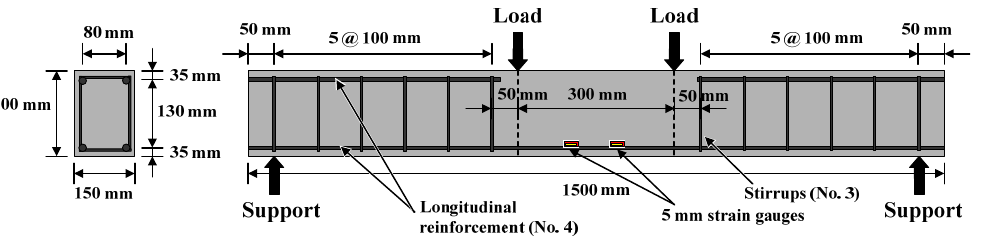
Figure 2. The details of the reinforcement used for the beam specimens.